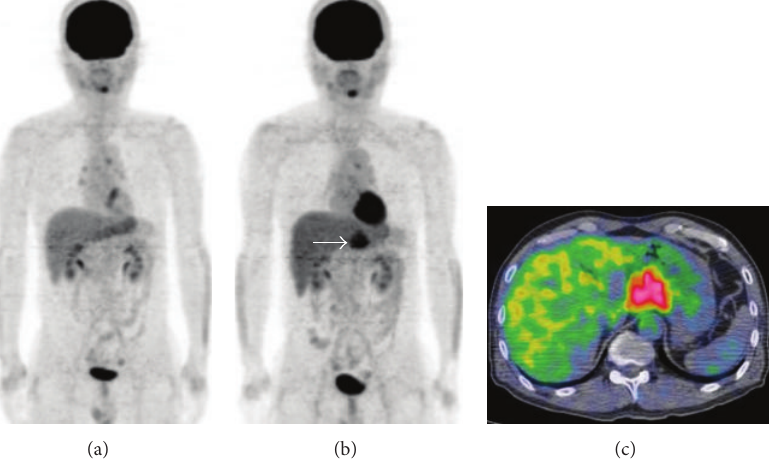
Figure 3: At the initial workup, a PET scan detected no positive tracer uptake in the whole body (a). However, an enlarged perigastric lymph node appeared 11 months after the initial diagnosis. The enlarged lymph node was positive for tracer uptake in the PET scan (b,